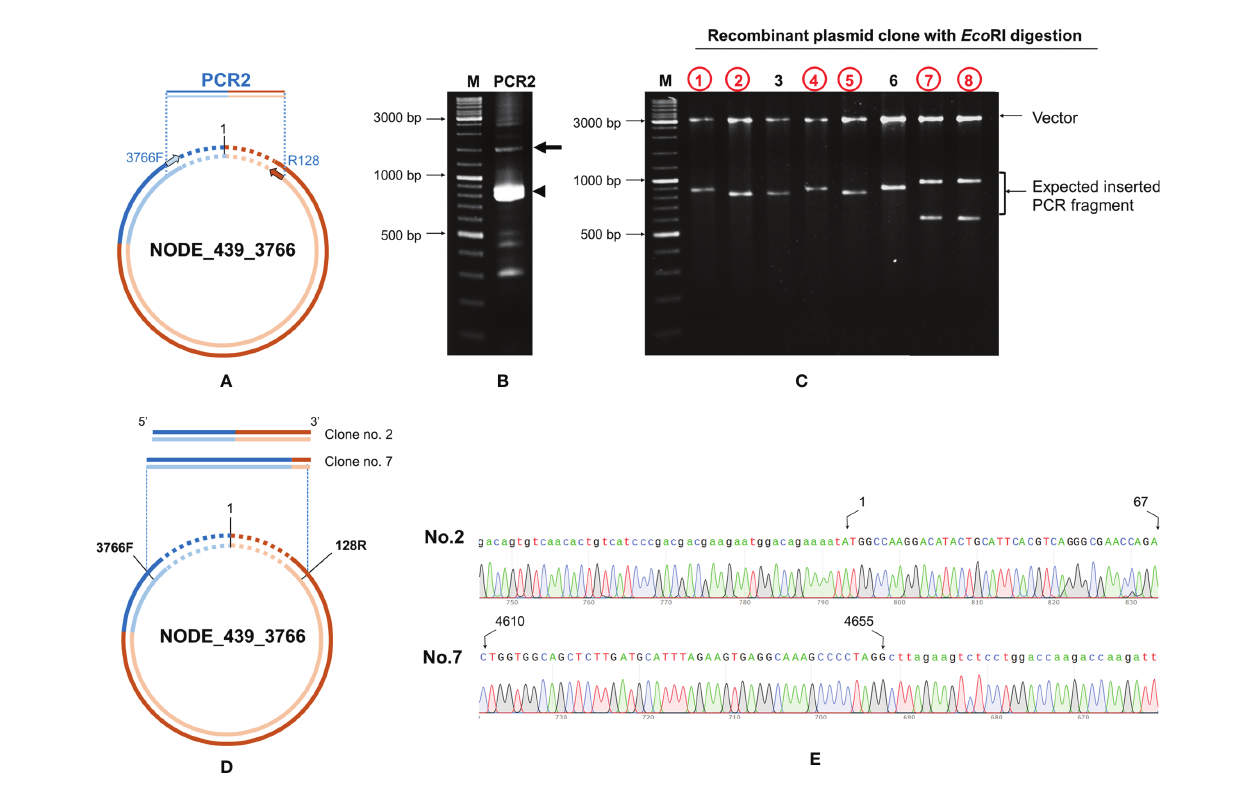
FIGURE 8 | Con fi rmation of cvcDNA sequences of NODE_439_3766 homologous to GenBank record DQ228358 by PCR and DNA sequencing. (A) Diagram showing the primer pairs designed for cvcDNA ampli fi cation. (B) The PCR amplicon was obtained from shrimp cvcDNA using single step PCR and con fi rming that the annotated cvcDNA sequences were closed circular forms. The expected PCR amplicon of approximately 1200 bp was observed (arrow). However, the majority of PCR amplicons were of smaller sizes (indicated by an arrowhead). (C) PCR fragment ligation and cloning to a plasmid vector revealed variation in the inserted PCR fragments. (D) Diagram showing the PCR sequence reads and alignments of the cvcDNA variants corresponding to the reference contigs no. NODE_439_3766. (E) Junction analysis of DNA sequencing obtained from PCR fragment sequences in (C) showing continuous DNA reads in the chromatogram linking the 3 ’ and 5 ’ ends of the reference sequence accession no. DQ228358. Extension of the shrimp retrotransposon was also observed (additional sequences indicated by lowercase